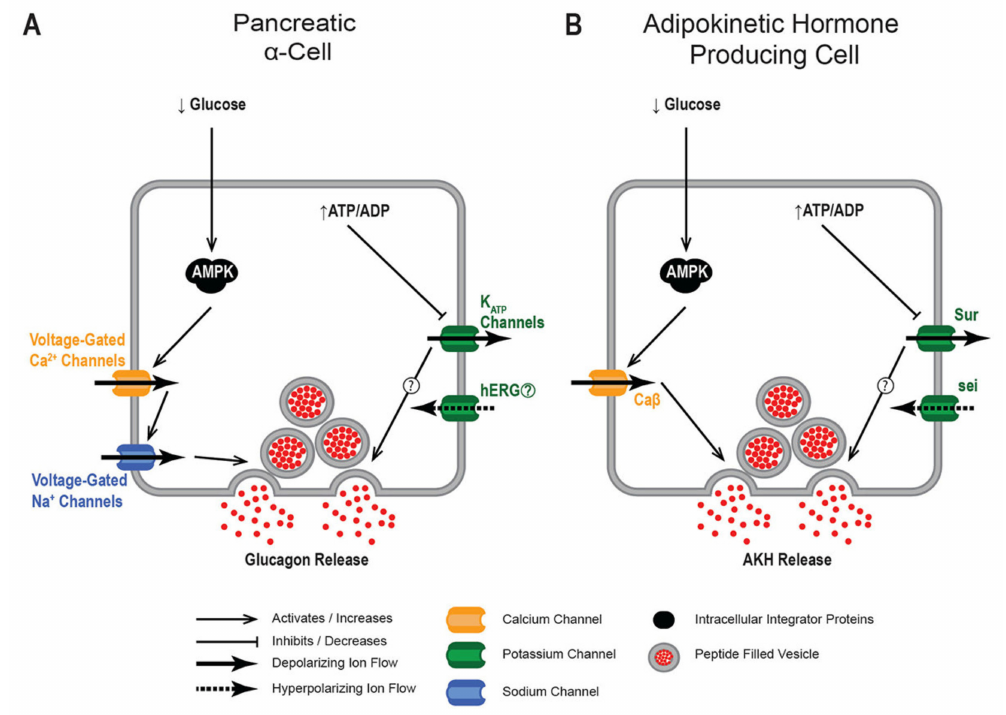
Figure 2. Functional similarities between physiological mechanisms of ( A ) pancreatic α cells and ( B ) APCs. APCs and pancreatic α cells possess many similar mechanisms that control the secretion of AKH and glucagon, respectively. Notably, AMPK and K + ATP channels are present in both cell lineages and function as nutrient sensors. The exact mechanism for how K + ATP channels function as a nutrient sensor is less clear in both cell types. Furthermore, the identities of many of the ion channels that regulate the excitability of each tissue are similar (specifically calcium and potassium